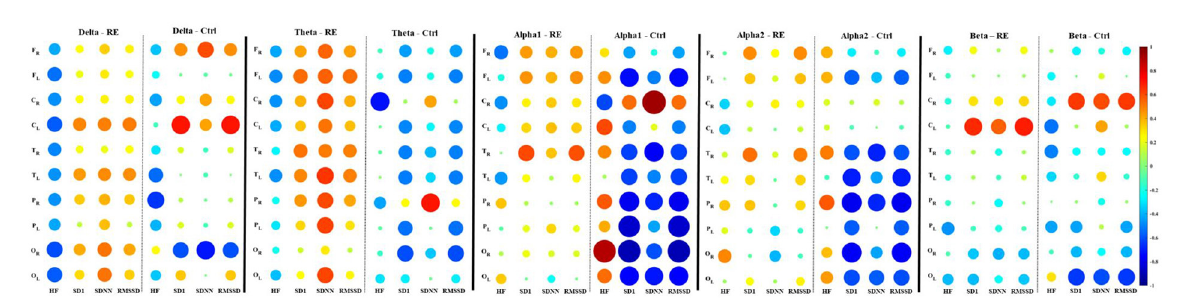
FIGURE2 Spearman correlation correlograms between EEG average power of frequency bands (Delta, theta, apha1, apha2, and beta) and HRV parameters for the refractory epilepsy (RE) and control (Ctrl) groups. In each correlogram, the HRV parameters correspond to columns and the rows correspond to the ROI from which the mean power was calculated (F, frontal; C, central; T, temporal; P, parietal; O, occipital). The subscripts R or L indicate the right and left cerebral hemispheres, respectively. Correlation values are indicated by color according to the scale bar on the right. The correlation values correspond to the radius of the